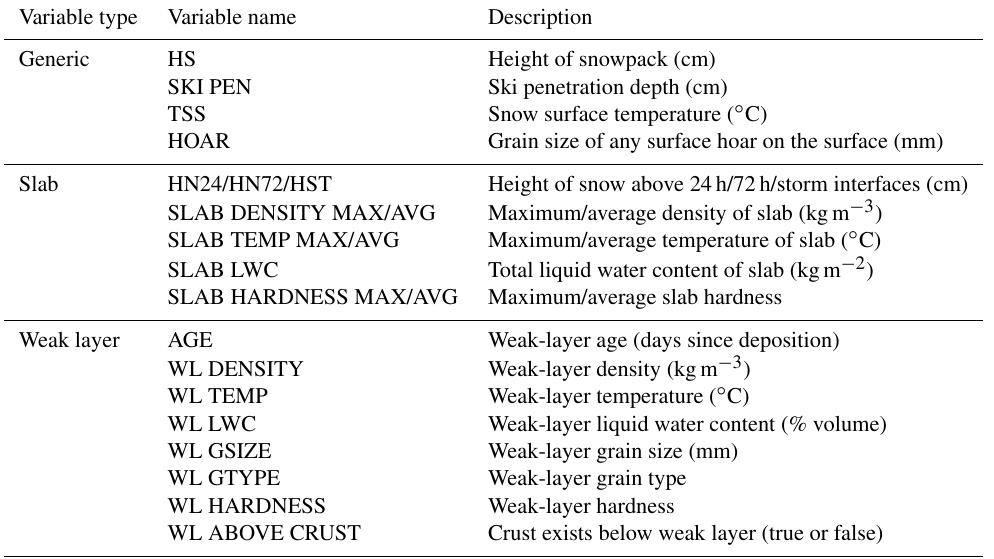
Table 3. Snowpack variables calculated from simulated snow